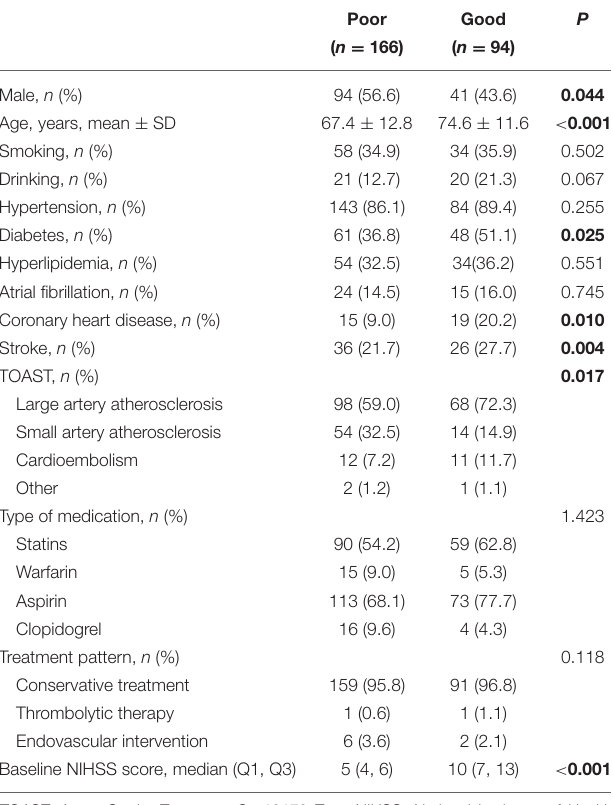
TABLE 4 | Subgroup univariable analyses of the factors associated with 90-day TABLE 2 | Univariable analyses of the factors associated with the 90-day outcomes in patients with ACI complicated with UIA. outcomes. Poor Good P Poor Good P